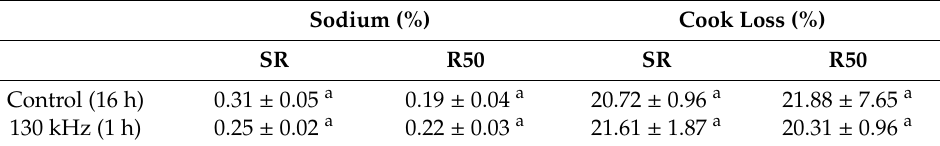
Table 5. Mineral content and cook loss of sodium-reduced chicken; effects of US processing (130 kHz) for 1 h on the sodium uptake (g/100 g of meat) of chicken breast marinated with a 1:2 substitution of NaCl with KCl (SR) or only with half of the original salt content (R50). Values are compared to samples marinated without ultrasound (Control) for 16 h. Values represents means ± standard deviation (SD, N = 4). Values followed by different letters in the same column are significantly different, at p < 0.05.